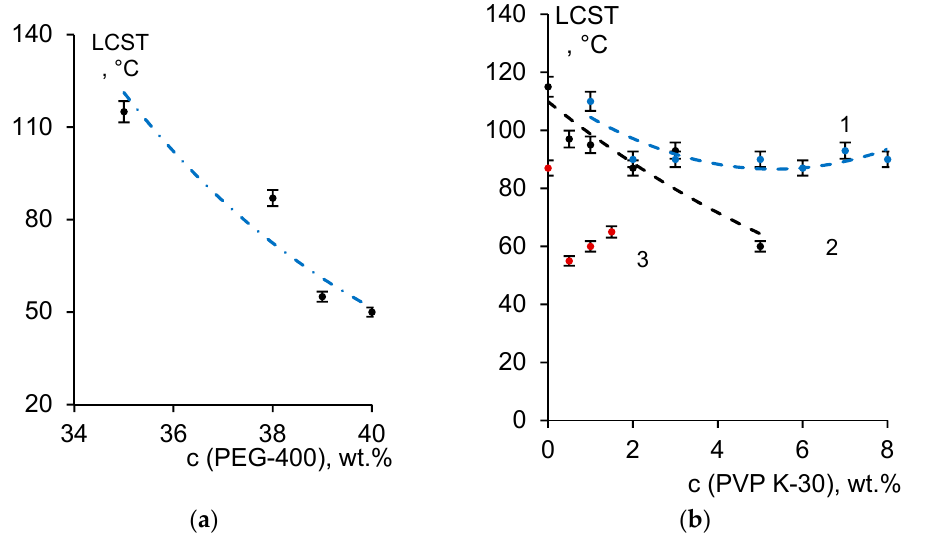
Figure 2. Dependence of LCST for ( a ) 20 wt.% PSF solutions in DMA on PEG-400 concentration and ( b ) 20 wt.% PSF solutions in DMA containing, 30 wt.% (1), 35 wt.% (2) and 38 wt.% (3) PEG-400 on PVP K-30 concentration.